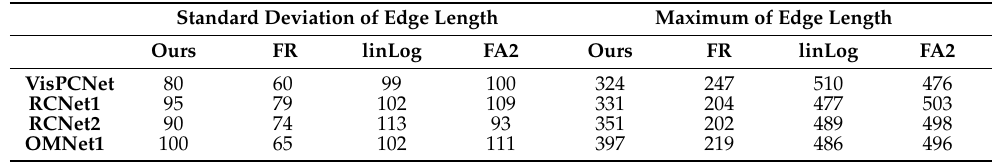
Table 4. Metric comparison of edge